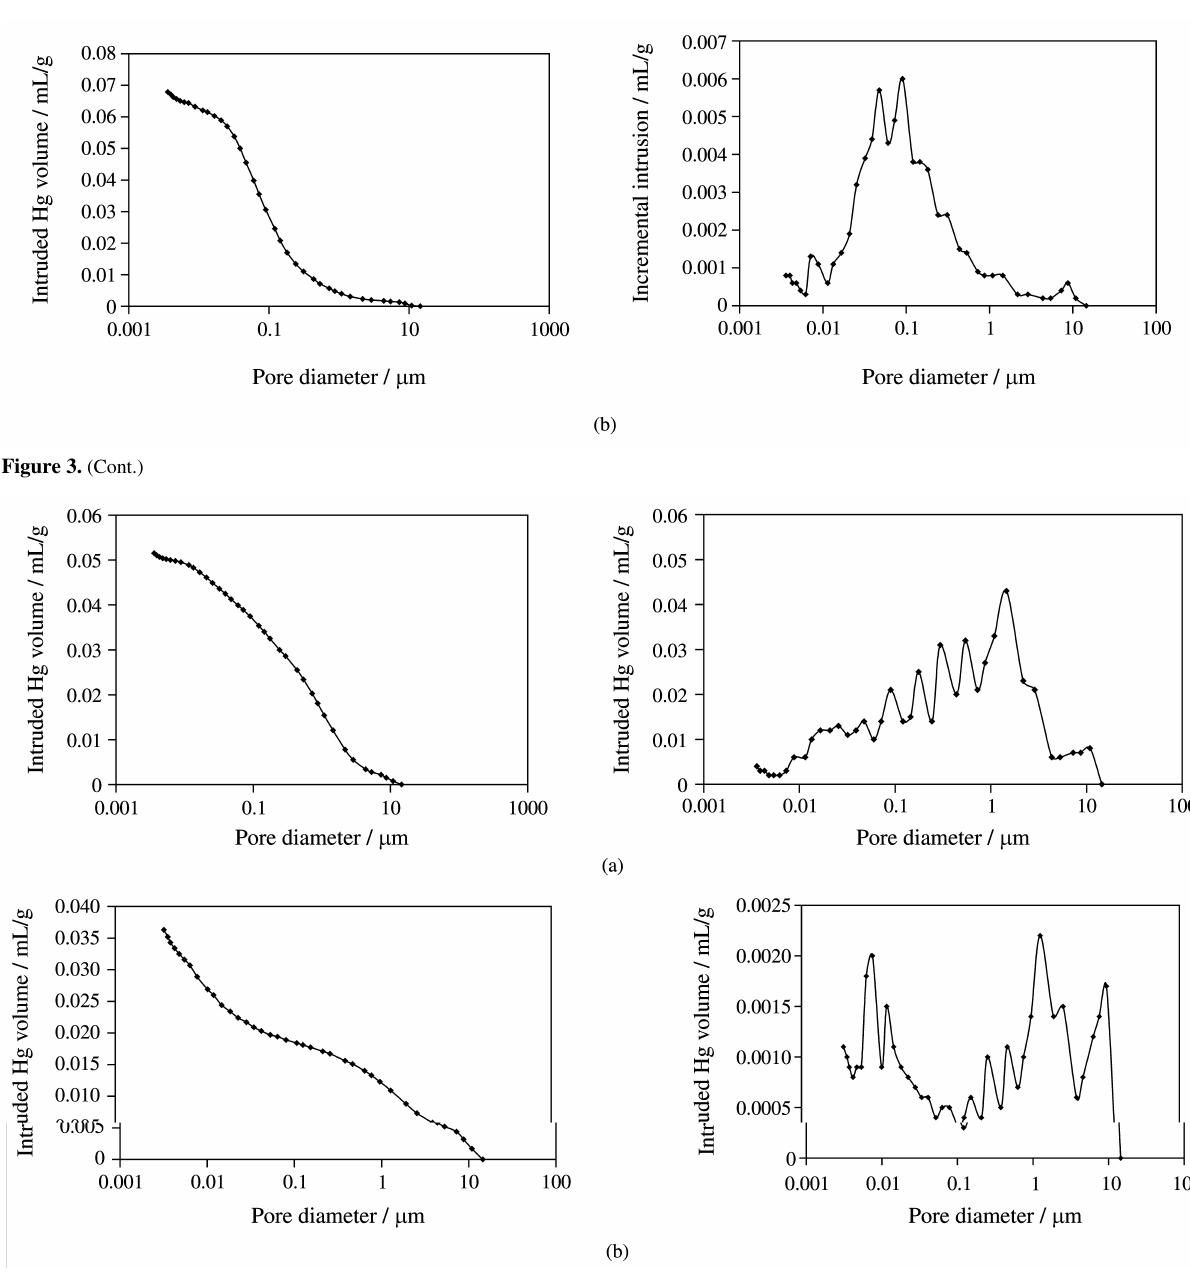
Figure 4. Intruded Hg volume vs. pore diameter curves and incremental intrusion vs. pore diameter curves, obtained from mercury intrusion porosimetry tests of specimens heat-treated at 600 °C: (a) f ck of 20 MPa; (b) f ck of 50 MPa. Table 3. Median pore diameter measured by mercury intrusion poro- simetry.